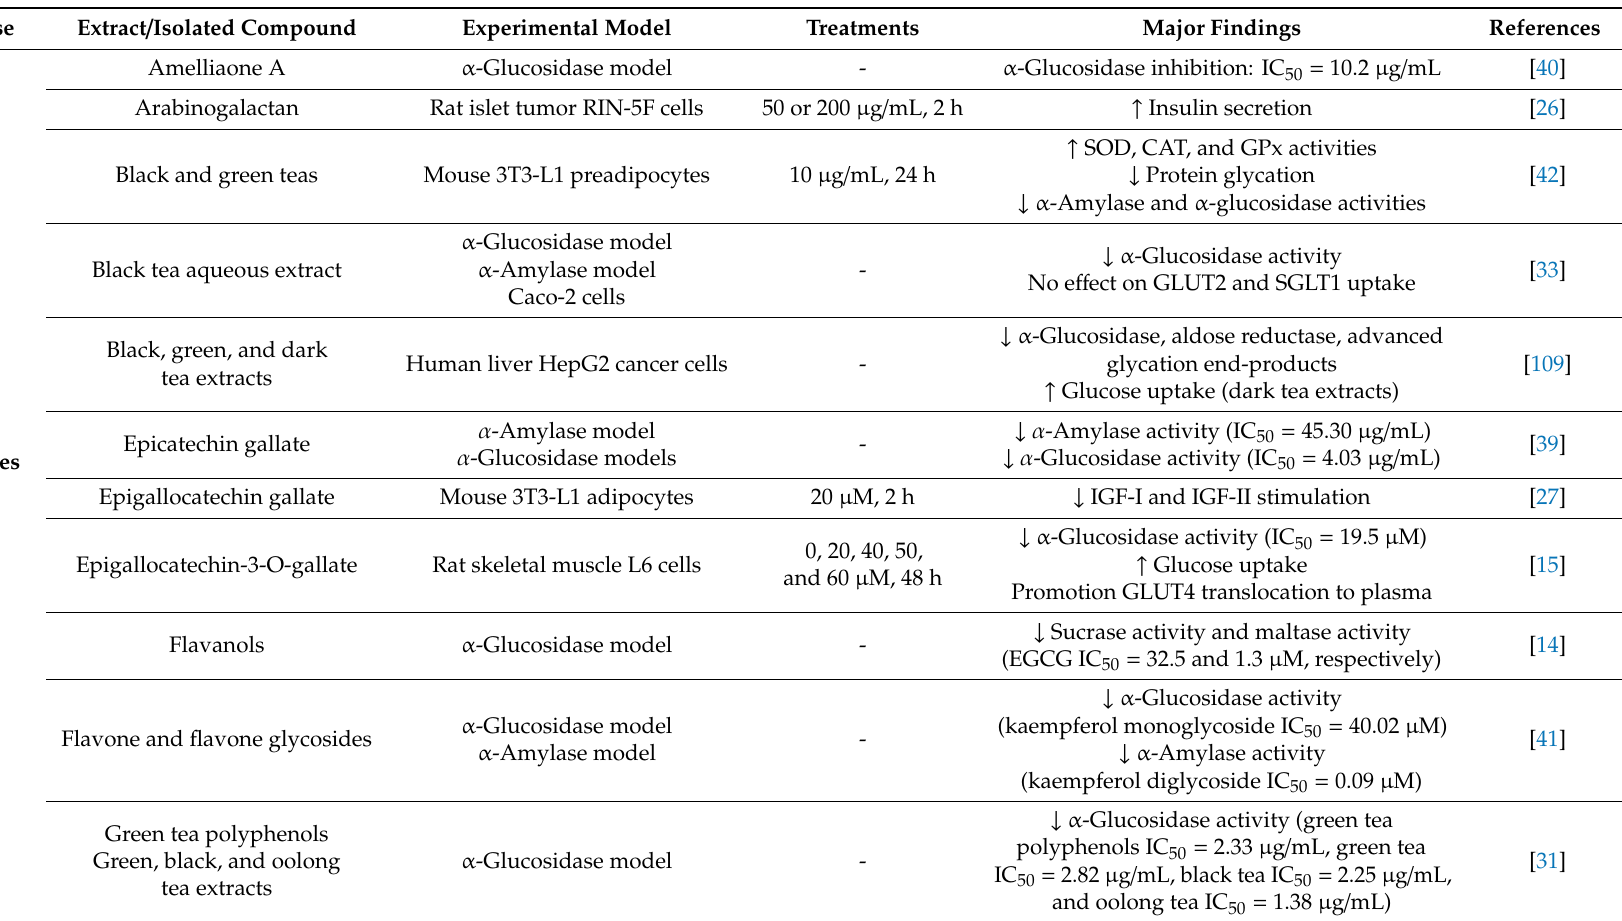
Table A1. In vitro pharmacological studies for Camellia